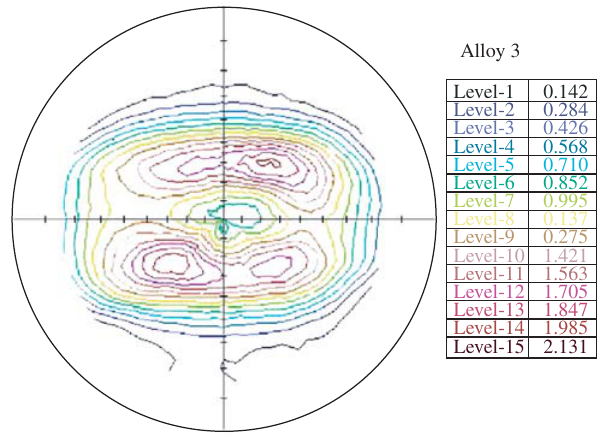
Figure 6. Laue photograph of the specimen taken from alloy 2, radial direc- tion. The diffraction lines have a continuous and uniform intensity appearance, which indicate a random crystal orientation.